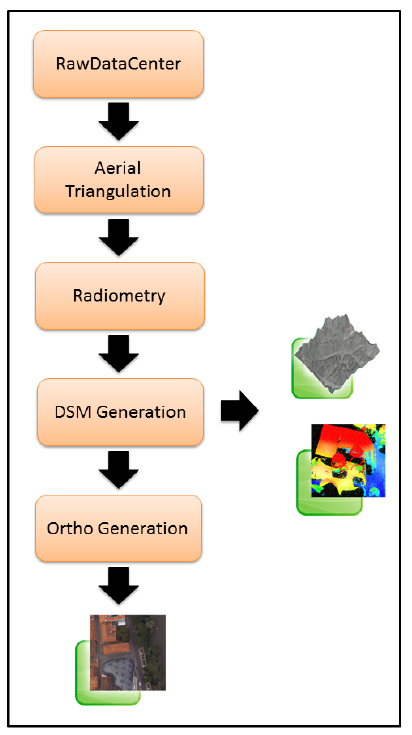
Figure 1 UltraMap v3 processing